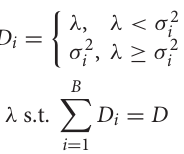
Frontiers in Neuroscience |